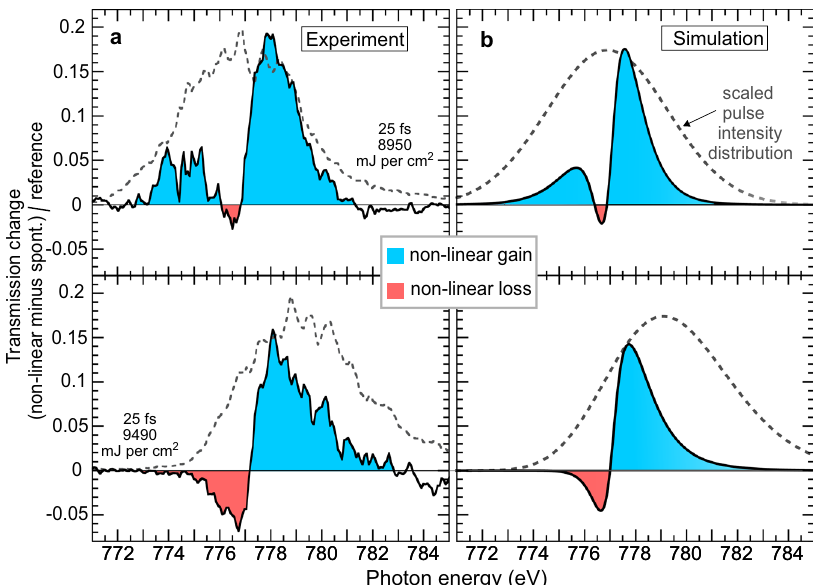
Fig. 4 Comparison of nonlinear spectra model to experiment. Here, spont. stands for spontaneous. a Experimental high- fl uence non-linear effects for 25 fs pulses taken from Fig. 2f, h. b Simulated results with our model for similar incident intensity distributions, plotted on the same scale. The shown simulated curves are the black curves in Fig. 3b,